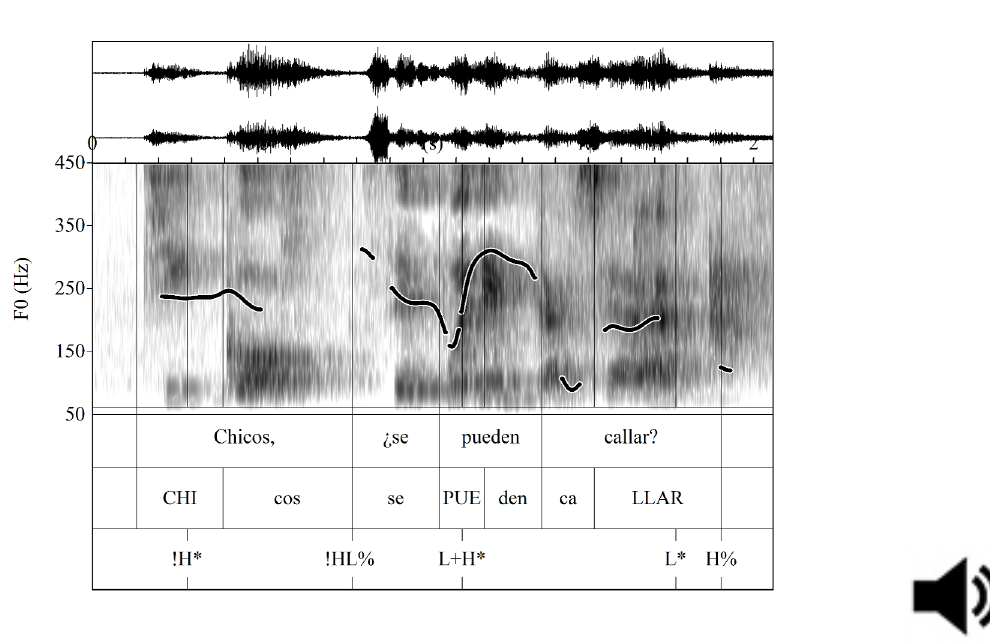
Figure 30 (Participant 20): Waveform and F0 trace for the vocative within the imperative yes-no question ¿ Chicos, se pueden callar? ‘Kids, can you please be quiet?’ produced as one IP realized as !H* (nuclear accent) and !HL% (boundary